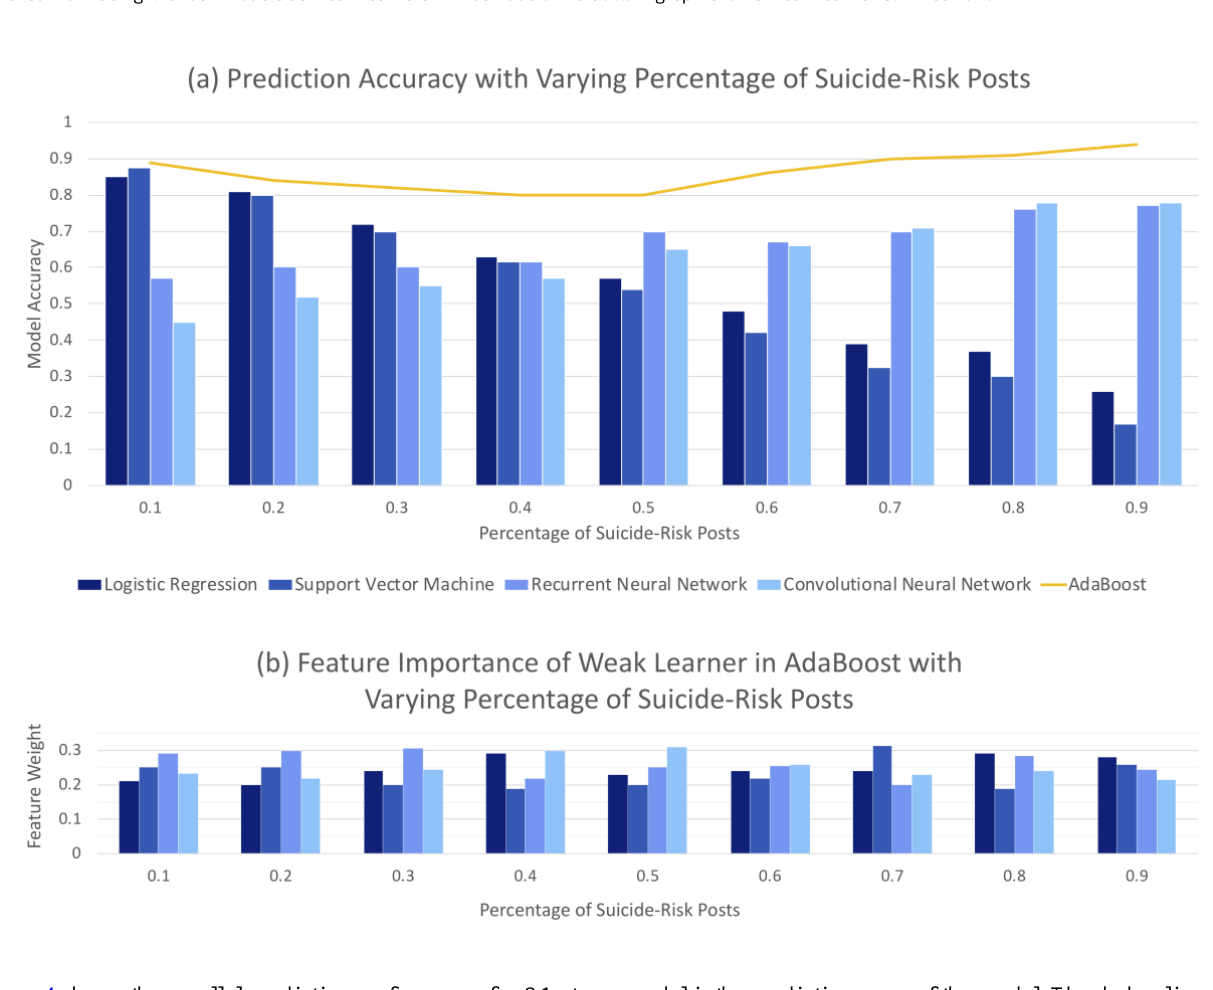
Figure 3. The top bar graph shows changes in prediction performance in C1 depending on data category ratios. The overlaying line plot shows accuracy achieved from using the four models as weak learners in AdaBoost. The bottom graph shows weak learner contribution.